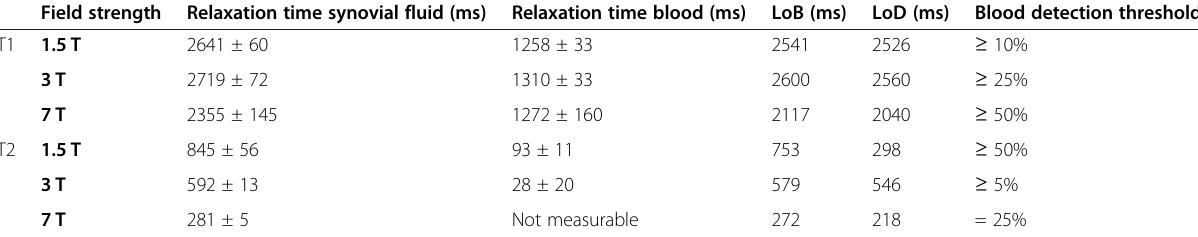
Table 2 Experimentally estimated T1 and T2 values for synovial fluid, blood, LoB, LoD, and blood detection threshold at 1.5, 3, and 7 T Field strength